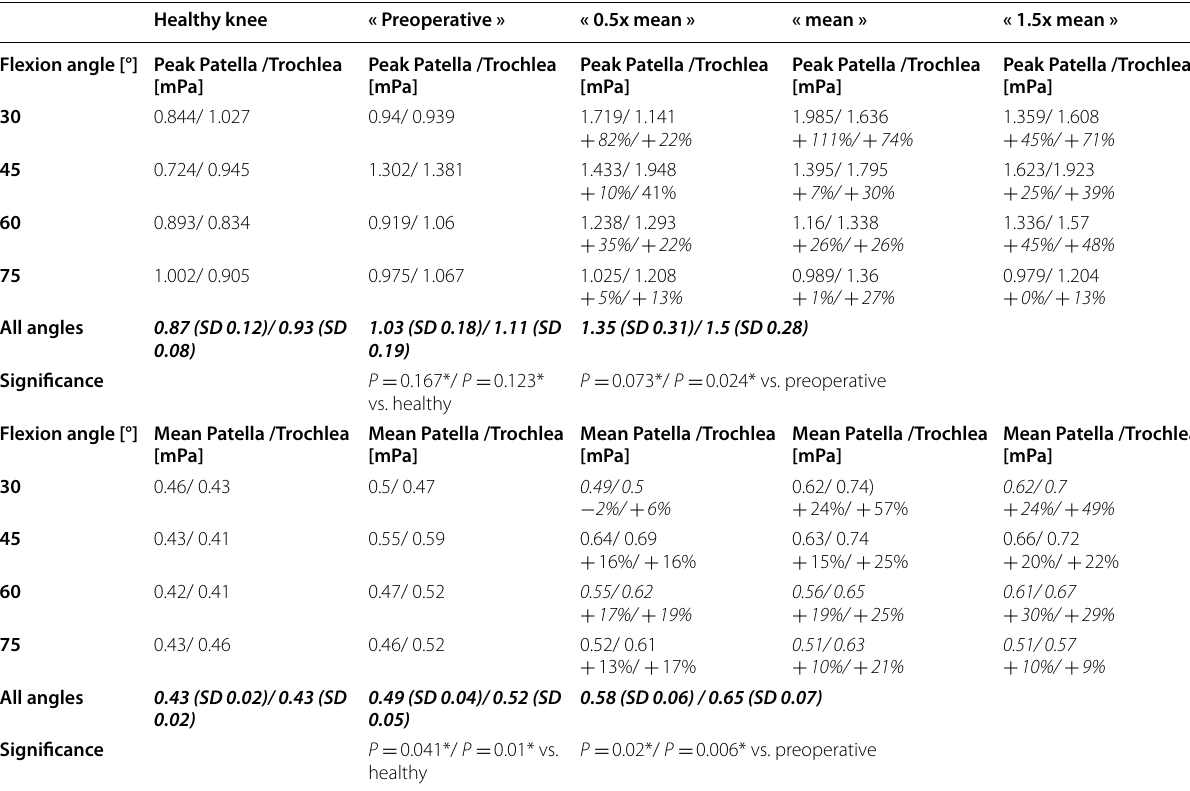
Table 2 Peak and mean equivalent stress (Von Mises) at the patellar and the trochlear cartilage are shown in the healthy knee and the trochleodysplastic knee “preoperative” and after simulated surgery at different flexion angles. “Welch’s t-test. Healthy